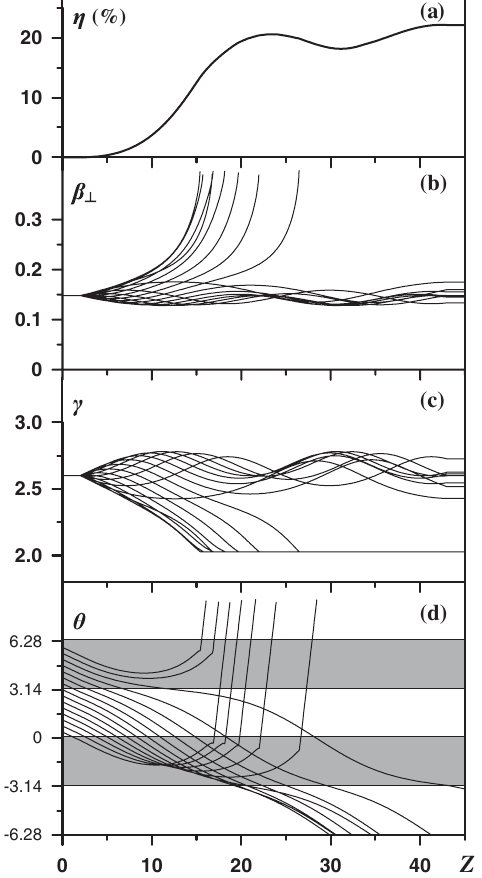
FIG. 10. FEL with a weak conventional guide field driven by an ideal electron beam. Dependence on longitudinal coordinate of (a) electron efficiency as well as (b) transverse velocity, (c) energy, and (d) phase with respect to the rf wave for electrons ¼ 2 : 6 , (cid:4) ¼ 0 : 15 , (cid:4) ¼ 0 : 15 , with different initial phases: (cid:3) w s 0 ¼ 0 : 25 , g ¼ 6 : 5 , (cid:4) ¼ (cid:2) 0 : 28 f ¼ 1 : 2 , (cid:9) 0